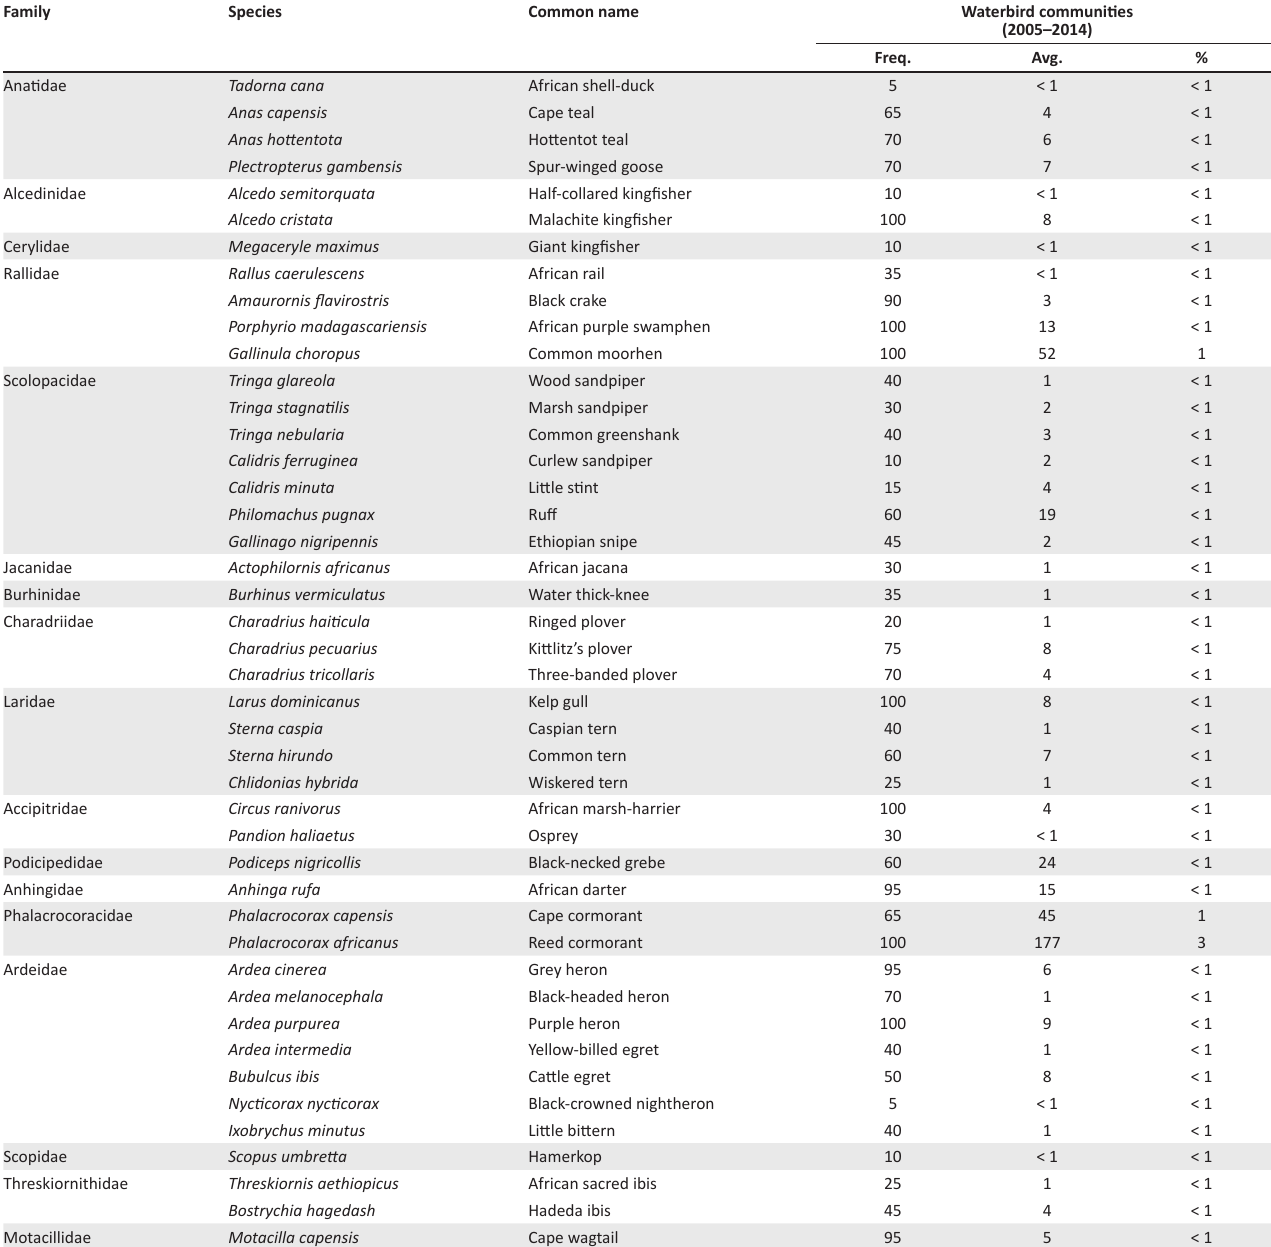
TABLE 3: Population statistics of waterbird species not affected by botulism. For waterbird communities surveyed biannually in Rondevlei, Langvlei and Eilandvlei over 10 years (2005–2014) prior to the initial outbreak of botulism. Family